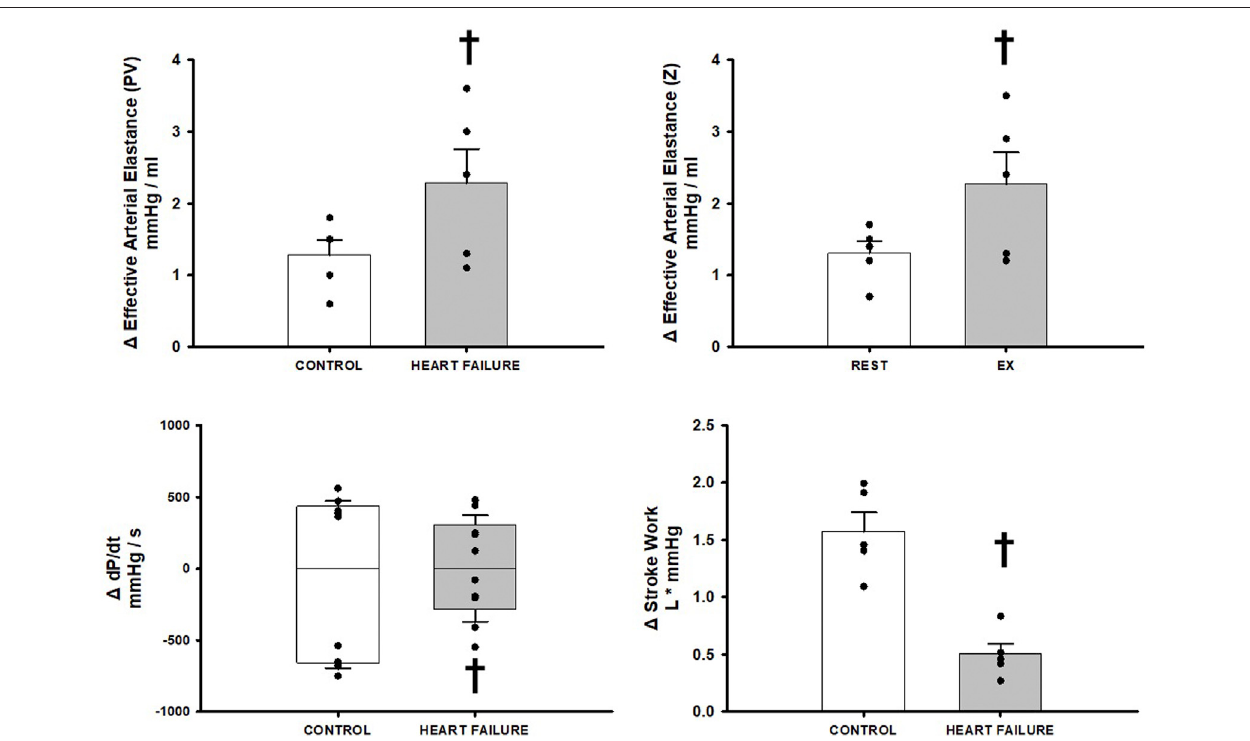
FIGURE 4 | Relative change in hemodynamic variables between exercise and exercise with baroreceptor unloading via bilateral carotid occlusion in control (white bars) and after induction ofheart failure (grey bars). Datareported asmeans witherrors bars depicting the standard errorofthe mean. Observeddata points areoverlain on corresponding bar graphs. Statistical signi fi cance depicted as † where p < 0.05. ( N =